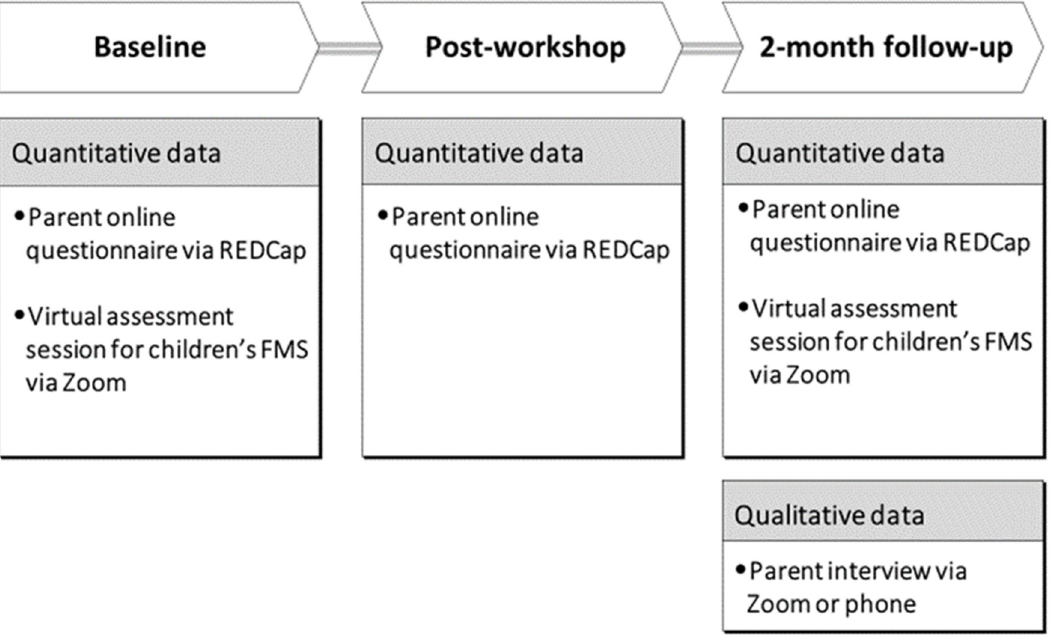
Figure 2. Overall procedures for data